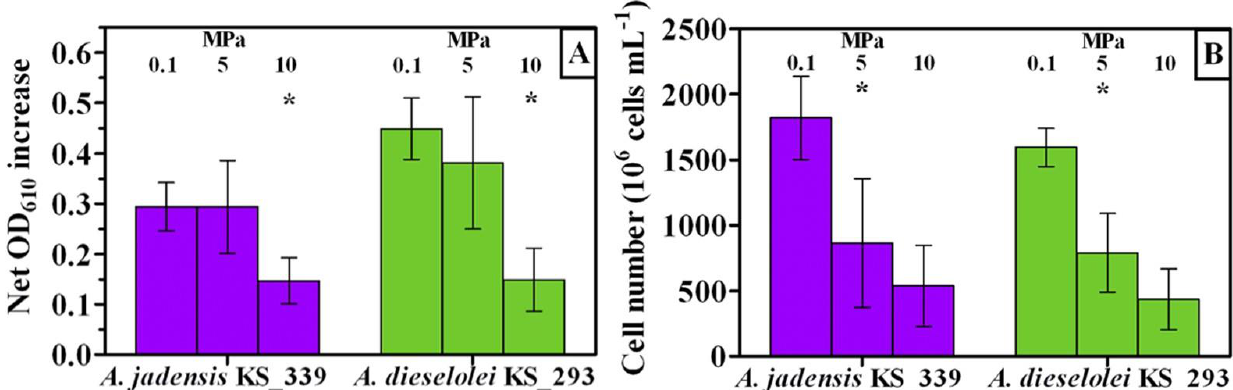
Figure 11. Growth of A. jadensis KS_339 (purple) and A. dieselolei KS_293 (green) under atmospheric (0.1 MPa) and mild pressure (5 and 10 MPa). Adapted from Scoma et al. [141] (Asterisks denote p - values: * < 0.05). ( A ): Net optical density increase. ( B ): Final cell number. According to the study of Prince et al. [143], the crude oil added to the seawater sample collected from Log Bay at 8 m deep was degraded faster by the indigenous